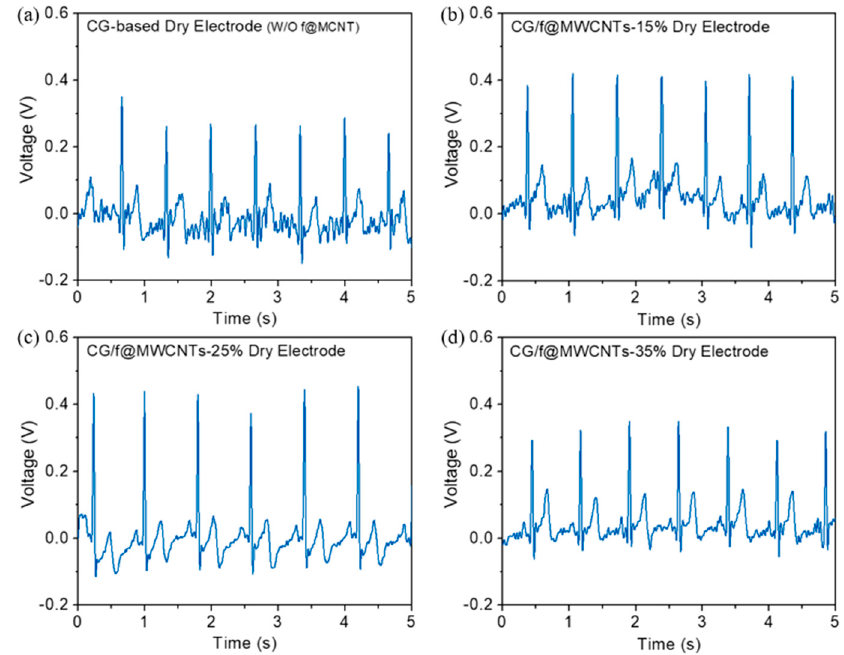
Figure 8. The ECG signal from the fingertips received by different flexible dry electrodes after finite impulse response (FIR) filtering for ( a ) CG, ( b ) CG/f@MWCNTs-15%, ( c ) CG/f@MWCNTs-25%, and ( d ) CG/f@MWCNTs-35%.